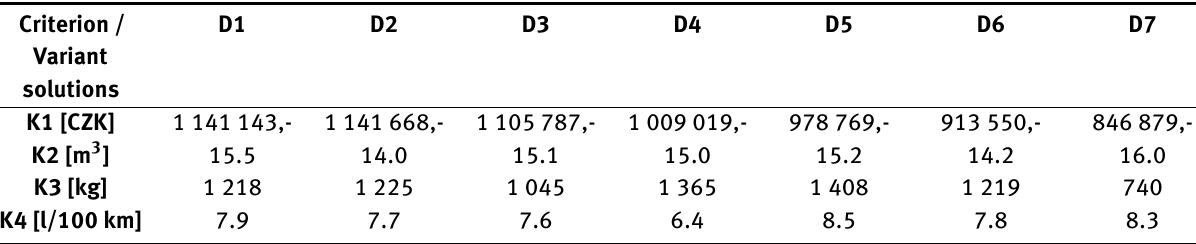
Table 1: Criteria values according to variant solutions [24]. Criterion /